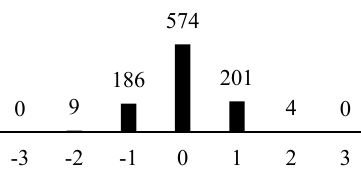
Figure 7. The number of convex polygons with each difference value.